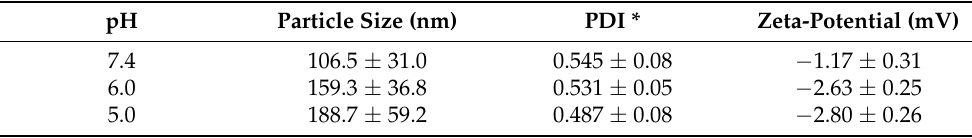
Table 1. Size and zeta potential of RES-UA NPs at various pH values.